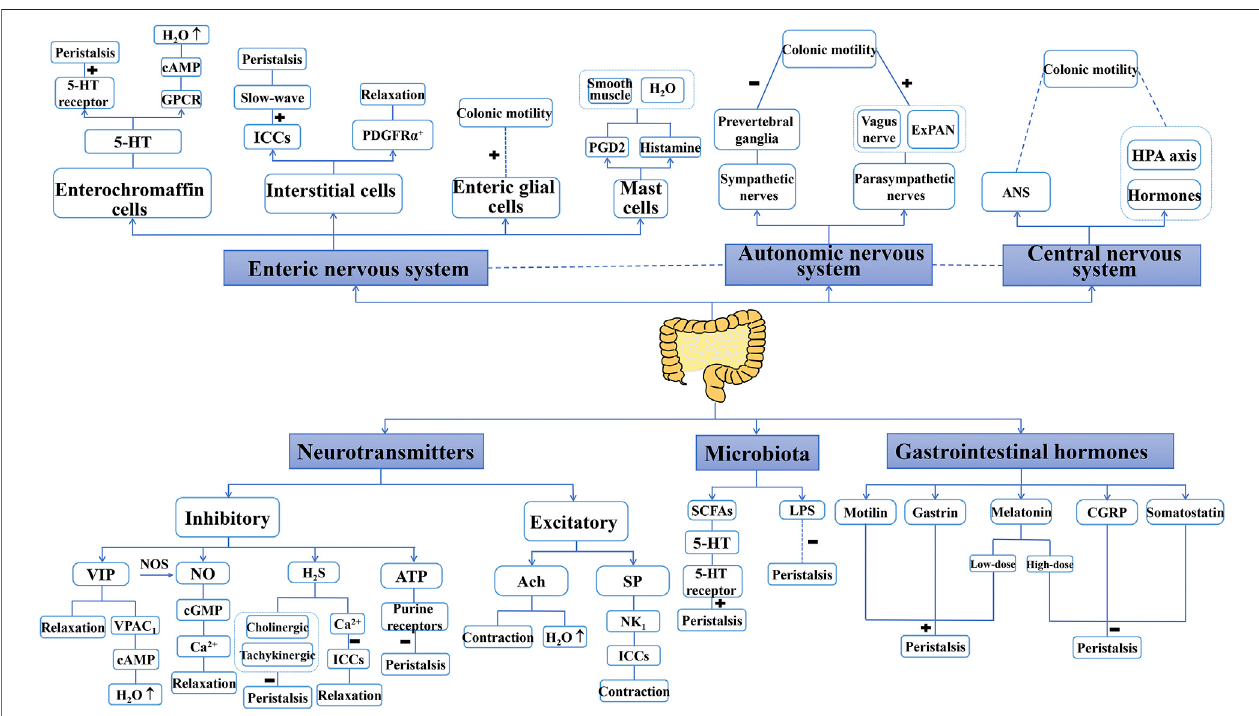
FIGURE 2 | Factors that modulate peristalsis. “ + ” indicate a promoting role, “ − ” indicate an inhibition role. Enteric nervous system, autonomic nervous system, central nervous system, neurotransmitters, gastrointestinal hormones and microbiota are the main factors to control peristalsis. Some of these factors also involve the secretion of water. 5-HT: 5-hydroxytryptamine; Ach, acetylcholine; ANS, autonomic nervous system; ATP, adenosine triphosphate; cAMP, cyclic adenosine monophosphate;cGMP,cyclicguanosinemonophosphate;CGRP,calcitoningene-relatedpeptide;ExPANs,extrinsicprimaryafferentneurons;GPCR,G-protein coupled receptors; HAP axis, hypothalamus – pituitary – adrenal axis; H 2 S, hydrogen sul fi de; ICCs, interstitial cells of Cajal; LPS, lipopolysaccharide; NK 1 , neurokinin 1; NO, nitric oxide; NOs, nitric oxide synthase; PDGFR α + , platelet-derived growth factor receptor α -positive; PGD2, prostaglandin D2; SCFAs, short-chain fatty acids; SP, substance P; VIP, vasoactive intestinal